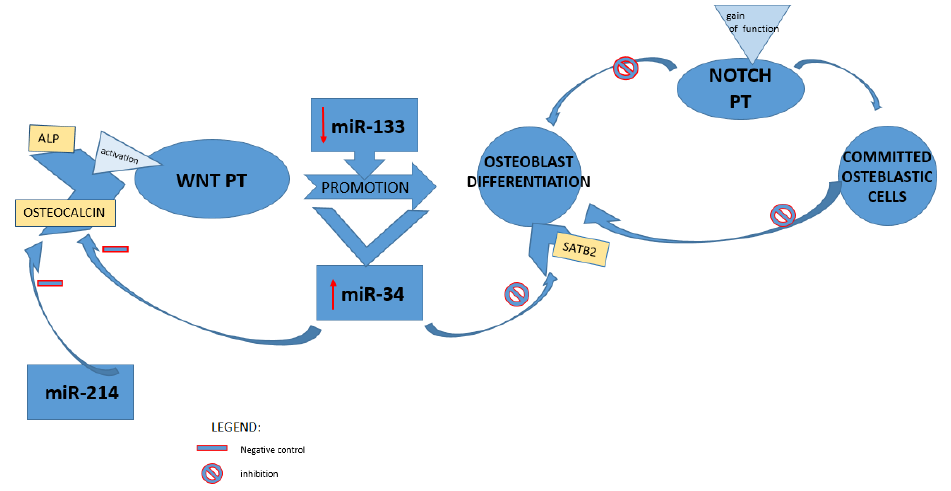
Figure 3. miRNAs and regulation of bone formation pathways. miR: microRNA; ALP: alkaline phosphatase; WNT PT: Wnt/ β -catenin pathway; NOTCH PT: Notch signaling pathway; SATB2: special AT-rich sequence binding protein 2.